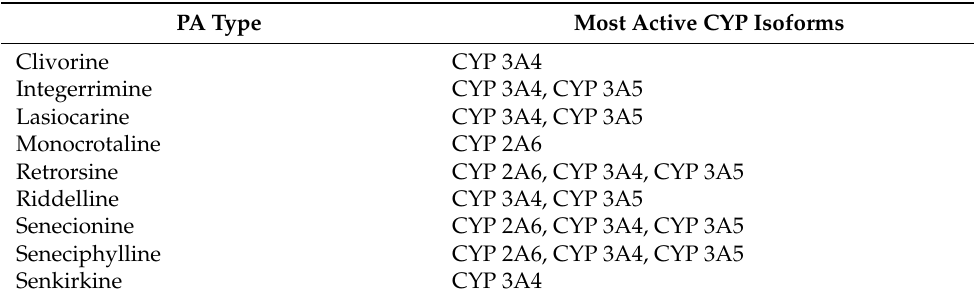
Table 4. Most active human liver CYP isoforms metabolizing unsaturated PAs. PA Type Most Active CYP Isoforms Clivorine CYP 3A4 Integerrimine CYP 3A4, CYP